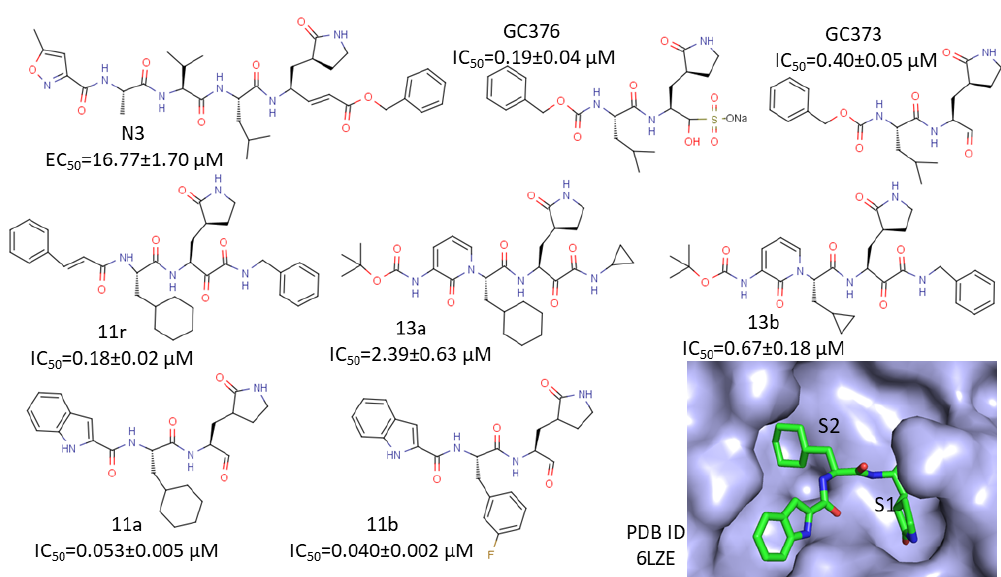
Figure 5. Some peptidic inhibitors of SARS-CoV-2. Structures and their half maximal inhibitory concentration values/ half-maximal effective concentration (IC 50 s/EC 50 s) against SARS-CoV-2 3CL pro are shown. The binding site 11a with SARS-CoV-2 3CL pro is shown. The inhibitor 11a is shown as sticks, and the protease is shown as a surface. S1 and S2 indicate the binding sites for P1 and P2 residues of the inhibitor.